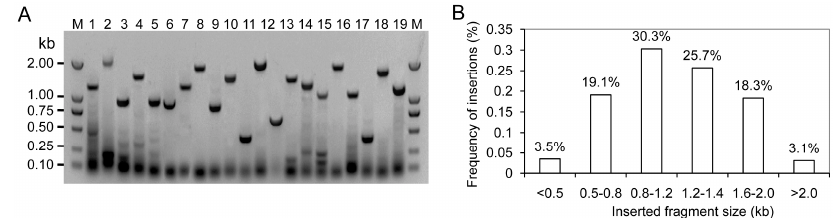
Figure 2. Length and fullness ratios of inserts evaluated by PCR amplification. ( A ) The partial results detected by PCR amplification. 1–19: Electrophoresis results of PCR production; M: Marker DL 2000; ( B ) The distribution frequency of inserts.